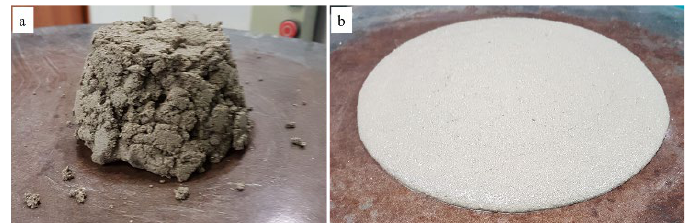
Figure 3. Spread Diameter HEMC – 10% (a), pAve – 10%